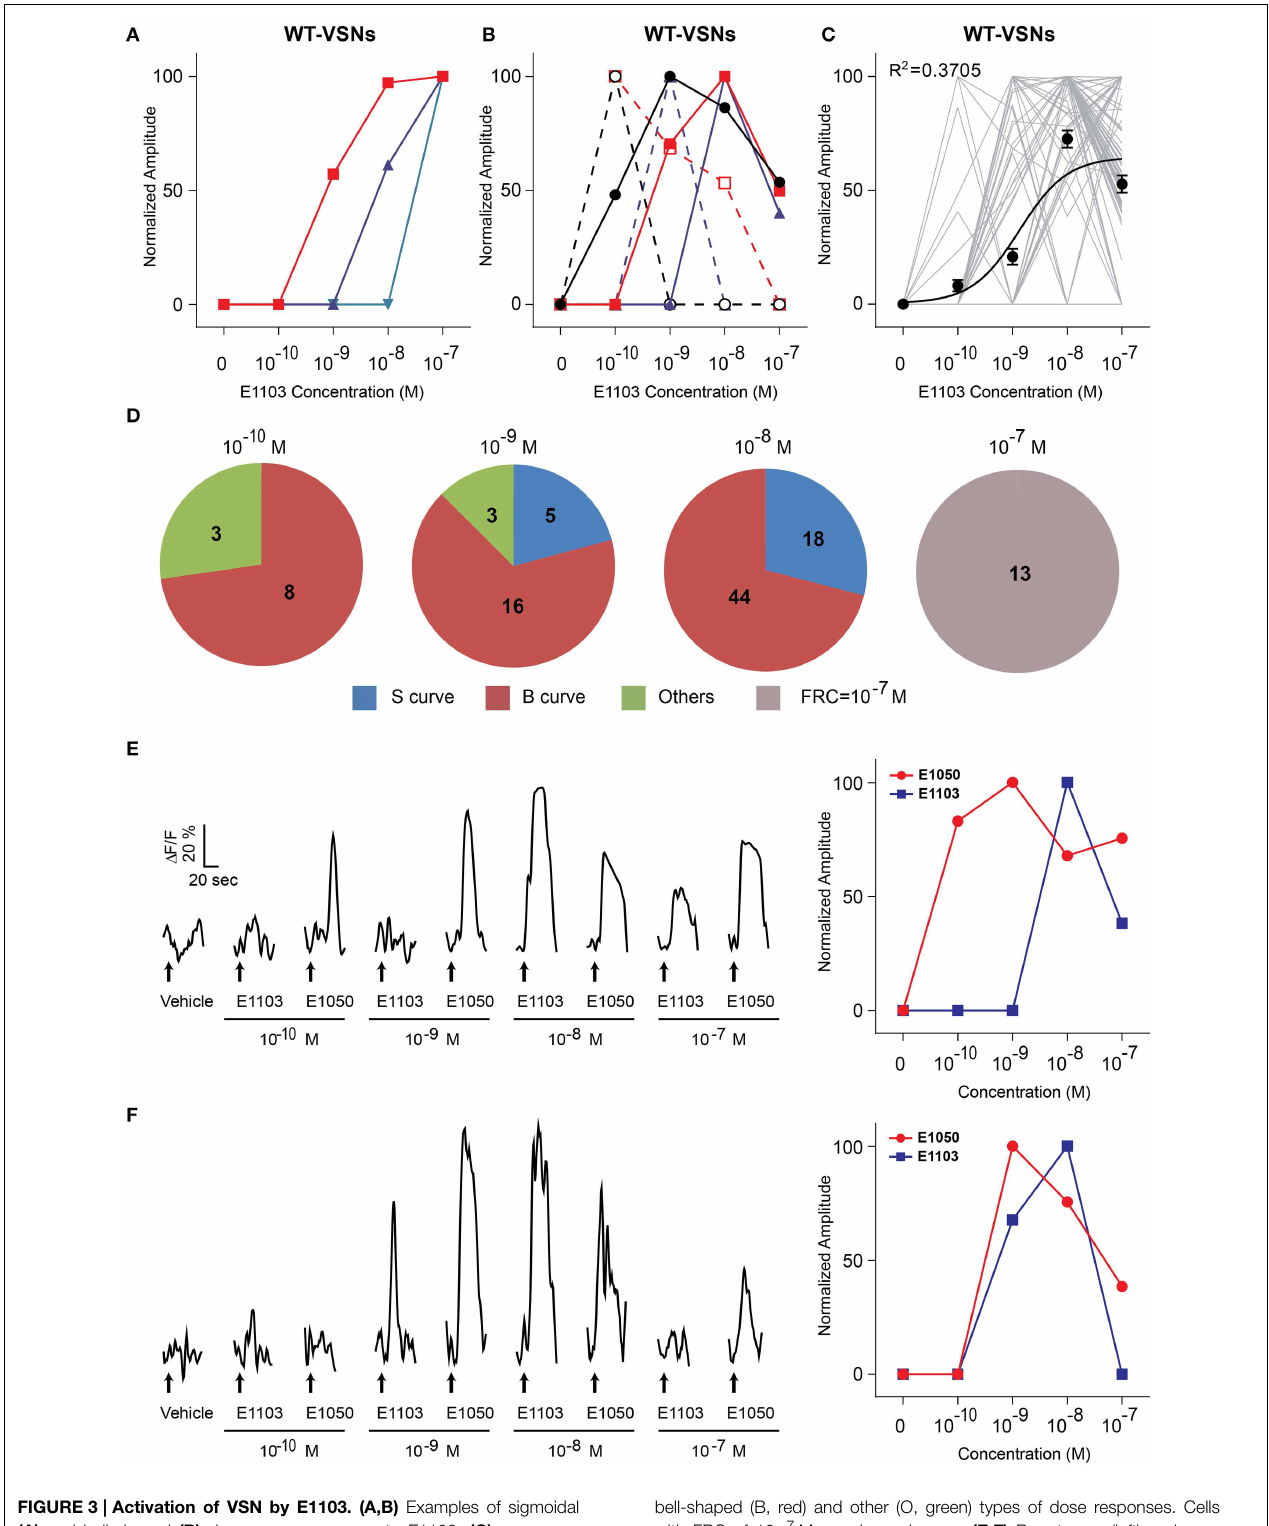
FIGURE 3 | Activation of VSN by E1103. (A,B) Examples of sigmoidal (A) and bell-shaped (B) dose-response curves to E1103. (C) Dose-response curves of individual cells (gray) and a sigmoidal curve (black) fitted to the average amplitude from all cells. Error bar, S.E.M. (D) Pie charts showing the number of cells exhibiting sigmoidal (S, blue),